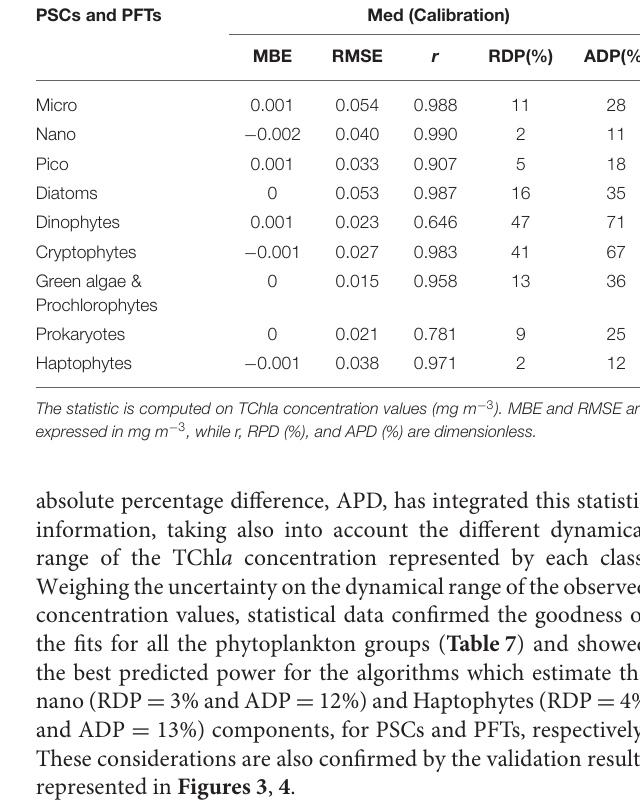
of Cryptophytes and “Green algae & Prochlorophytes” for the PFTs, followed by Haptophytes and Diatoms, and with the nano model for the PSC group. The study of the RPD and the mean